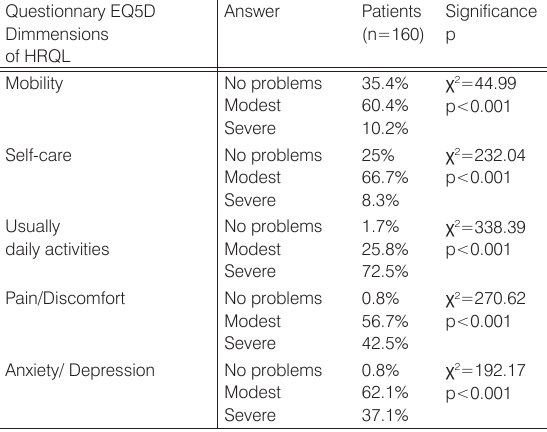
Table 4. The frequency of answers in EQ5D qustionnairy in patients